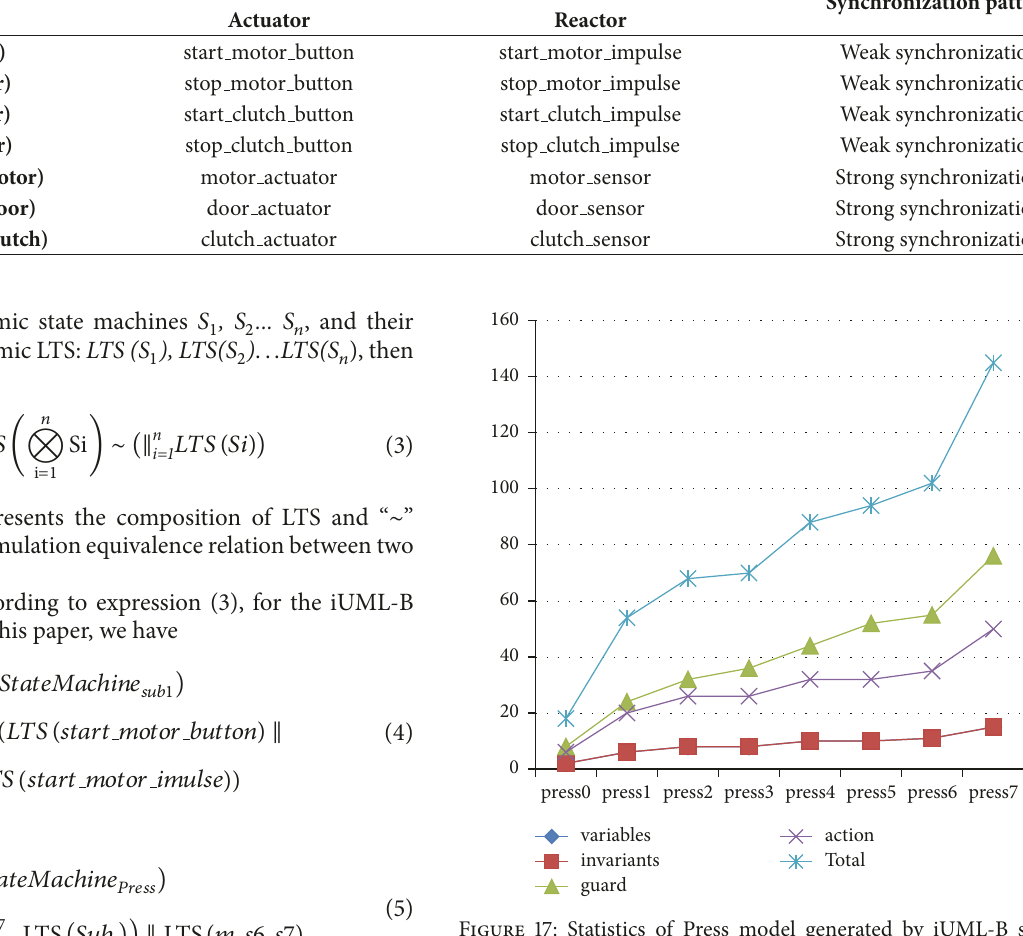
Figure 17: Statistics of Press model generated by iUML-B state